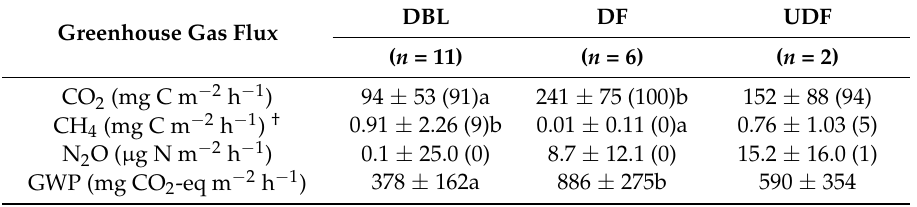
Figure 2. ( a ) CO 2 flux, ( b ) CH 4 flux, ( c ) N 2 O flux, and ( d ) global warming potential (GWP) in each plot of DBL (drained burned land), DF (drained forest), and UDF (undrained forest). Error bars show ±1 SD. Table 2. GHG (greenhouse gas) fluxes and GWP (global warming potential) in DBL (drained burned land), DF (drained forest), and UDF (undrained forest). GWP was based on radiative forcing over a 100-years’ time horizon: CO 2 = 1, CH 4 = 28, and N 2 O = 265. Values represent mean ± 1 SD (% relative contribution to GWP). Same letters denote not significantly different between DBL and DF ( p < 0.05).